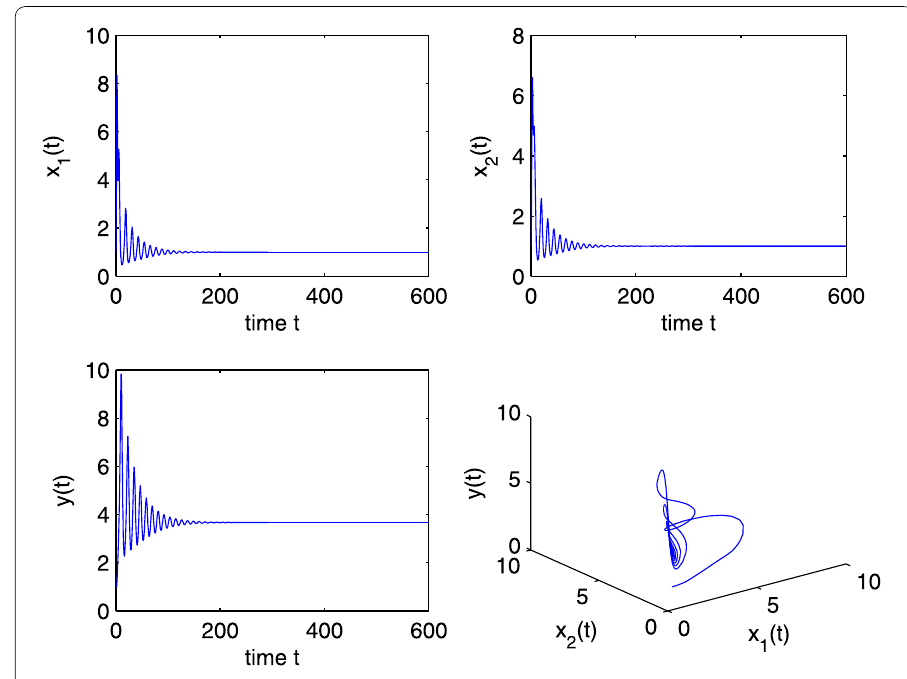
Figure 5 E ∗ is asymptotically stable for τ 1 = 1.4 < τ (cid:6) 10 = 2.3522 and τ (cid:6) 2 = 1.5